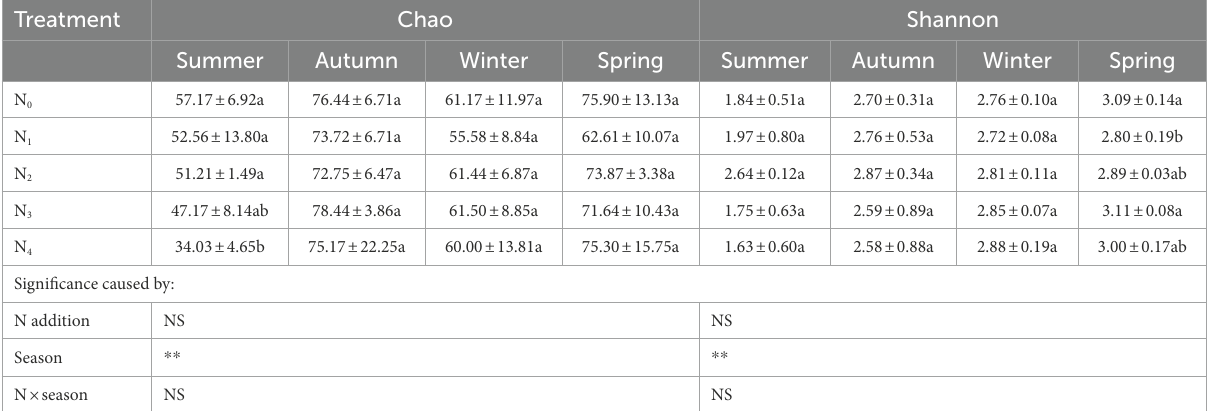
TABLE 1 Seasonal changes in the Chao and Shannon indexes of the AM fungal community in the poplar plantations with different nitrogen additions. Treatment